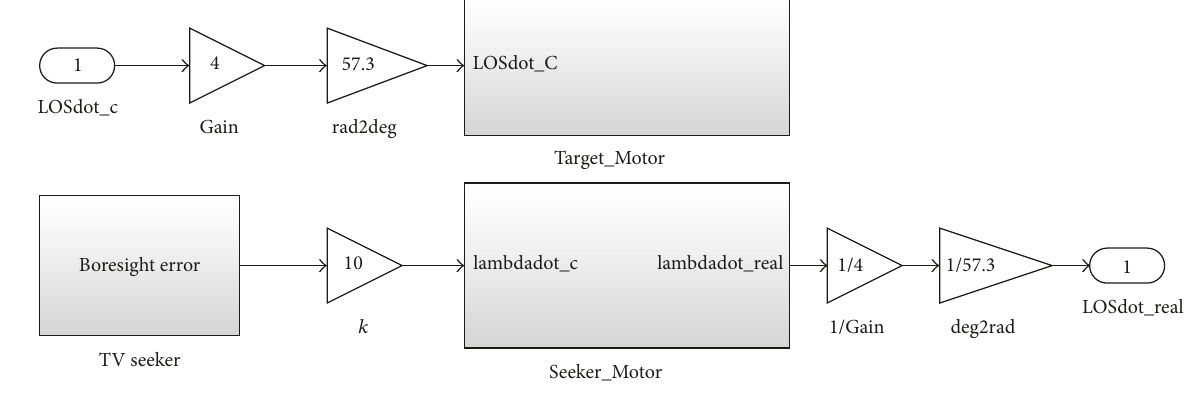
Figure 8: LOS subsystem.